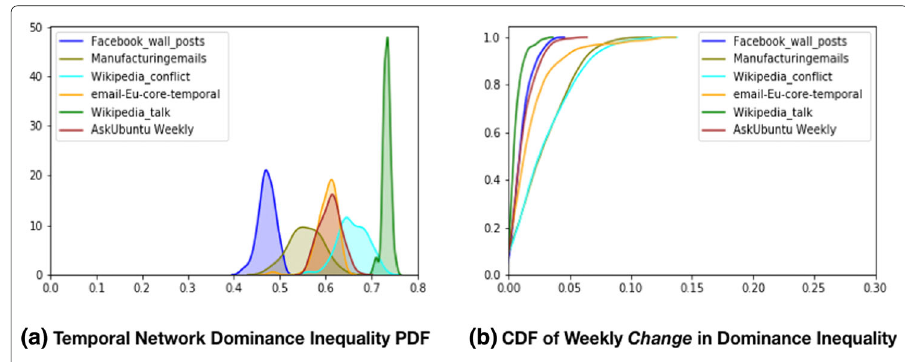
Fig. 5 Aggregated network measures: a The PDF of the weekly Temporal Dominance Inequality for each dataset. b The cumulative distribution of the relative change in the measured Temporal Dominance Inequality between every two consecutive weeks for each